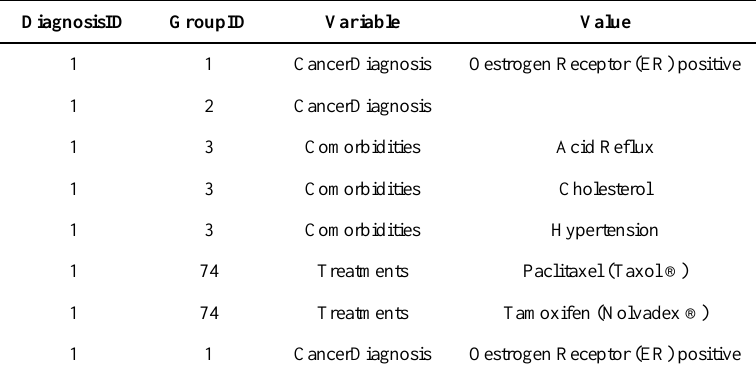
Table 1. Snapshot of CareAcross produced data